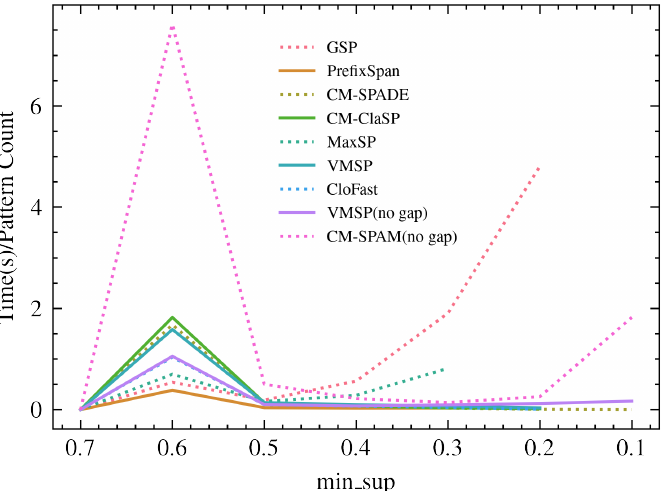
Figure 3. Comparison of algorithm efficiency through time(s) over pattern outputs at different min _ sup